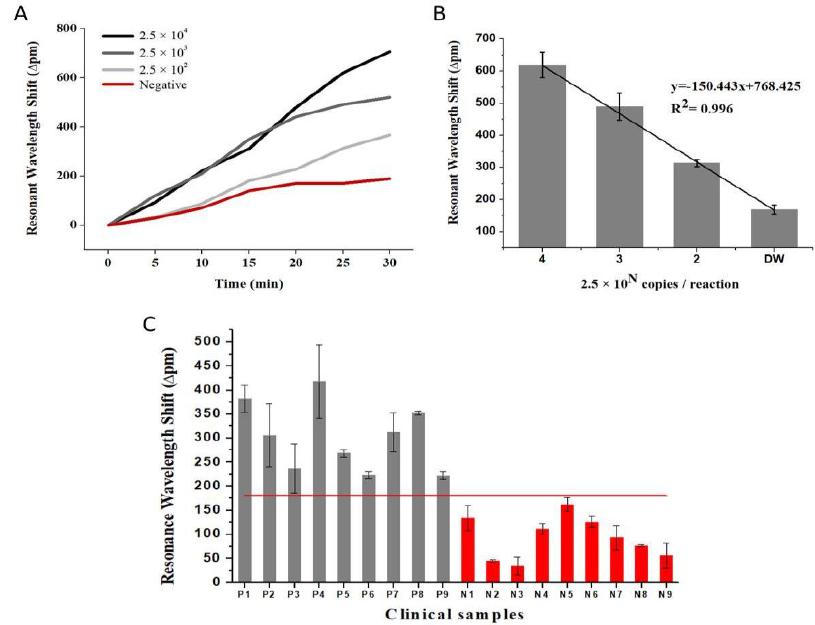
Figure 6. Optimization and validation of the ball-lensed optical fiber (BLOF) bio-optical sensor for clinical application, using Coxiella burnetii DNA and clinical samples. ( A ) Limit of detection of the bio-optical sensor assay for amplified C. burnetii DNA. The colors represent the amount of the target: 2.5 × 10 4 copies/reaction (black); 2.5 × 10 3 copies/reaction (gray with darker 75%); 2.5 × 10 2 copies/reaction (gray with darker 50%); and negative control (red). ( B ) Linear relationship between the wavelength shift and the target concentration in 25 min. ( C ) Bar chart showing the resonant wavelength shift results in 8 min per sample. The colors represent the detection of C. burnetii DNA (P, gray) in 9 blood samples from patients with Q fever and of no C. burnetii DNA (N, red) in 9 blood samples from patients with other febrile diseases. The red line indicates a cut off for positive and negative in 8 min. Error bars indicate the standard deviation of the